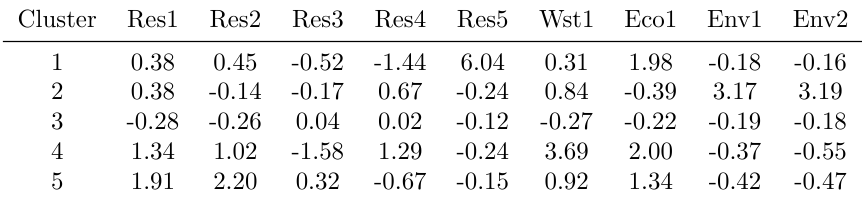
Table 3. In-cluster mean z-scores for regional context indicators by